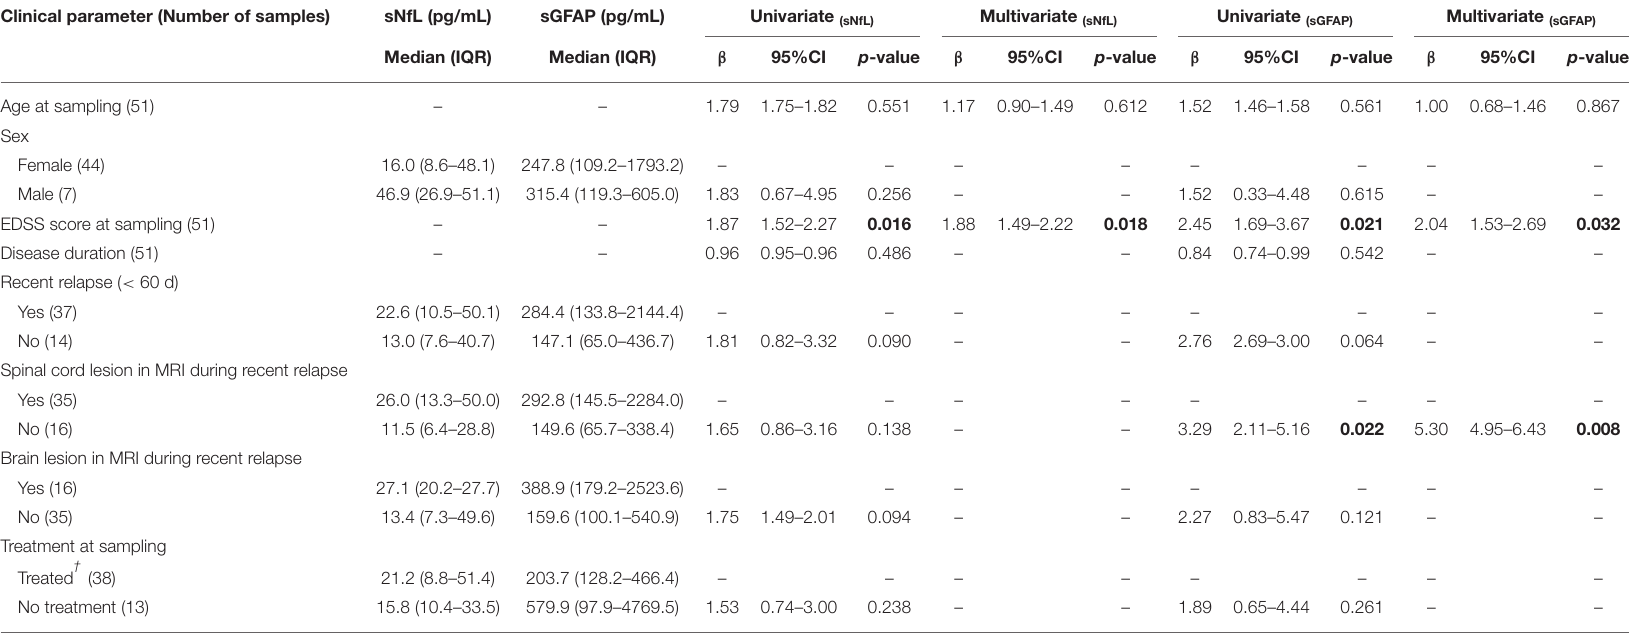
TABLE 2 | Clinical relevance of sNfL and sGFAP in AQP4-antibody-positive NMOSD examined by univariate and multivariate regression models. Clinical parameter (Number of samples)